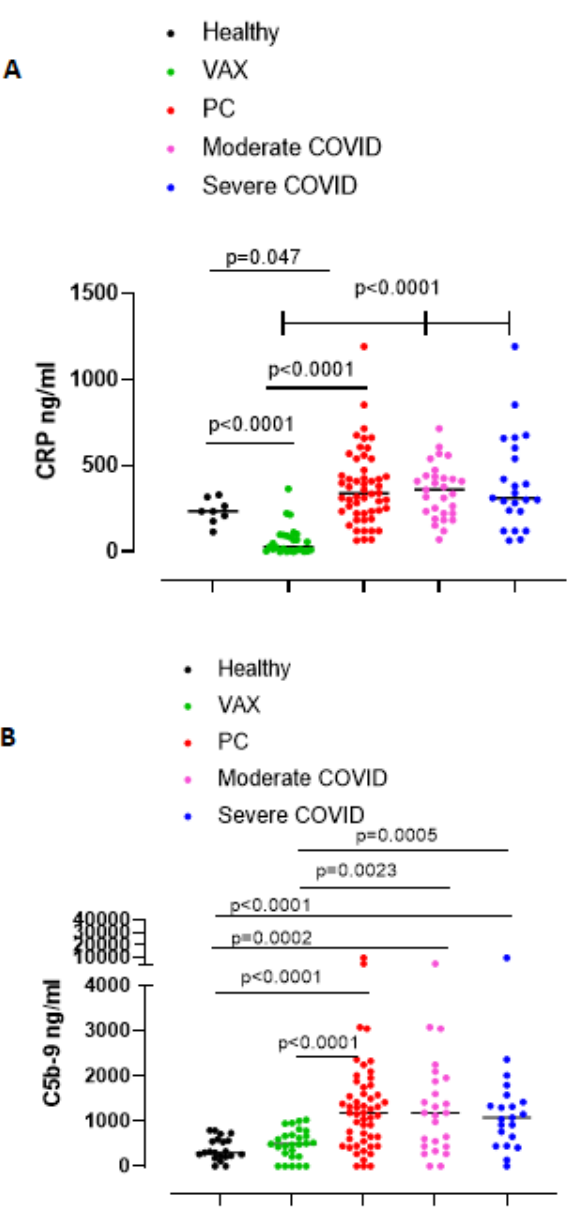
Figure 1. ( A ) Plasma levels of C-reactive protein (CRP) and ( B ) complement complex C5b-9 were significantly higher in PC patients than healthy (black dots) and vaccinated (VAX, green dots) subjects. Post-COVID-19 (PC) patients (red dots) were further stratified as moderate or severe patients (pink and blue dots, respectively). Data are expressed as median. Statistical analysis was performed according to the Mann–Whitney U test.